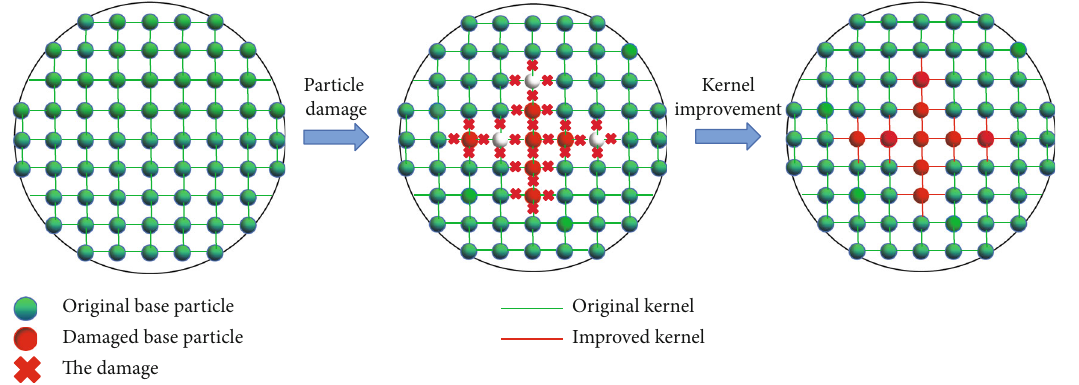
Figure 3: Treatments of particle